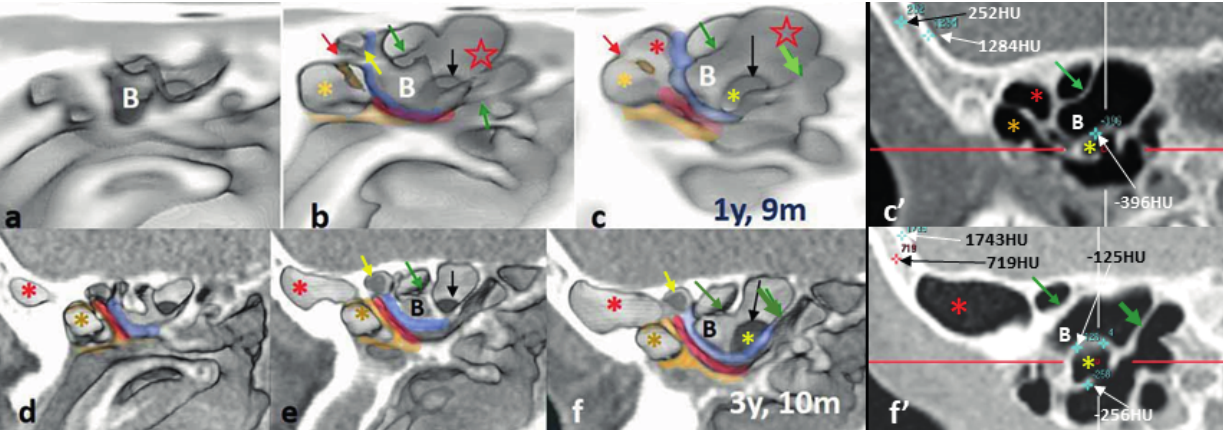
Figure 4. Early Ethmoid Sinus development over a two-year